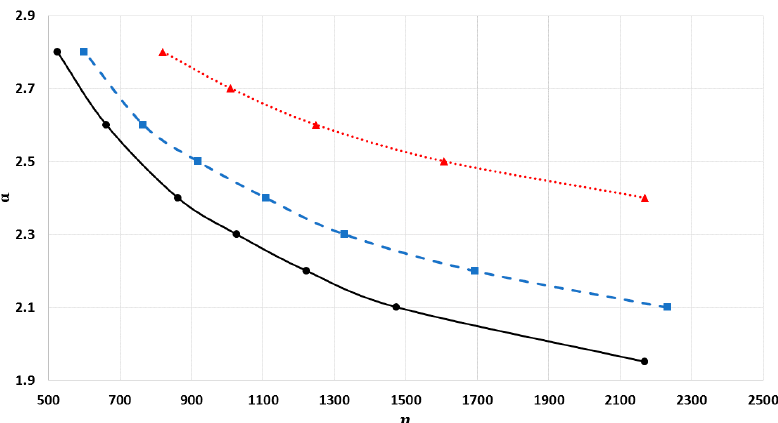
Figure 12. The variation of α with the number of atoms n for nanoparticles, having relative cohesive energies of approximately 0.686, and for di ff erent values of m : 4 (black solid line and circles), 3 (blue dashed line and squares), and 2 (red dotted line and triangles).